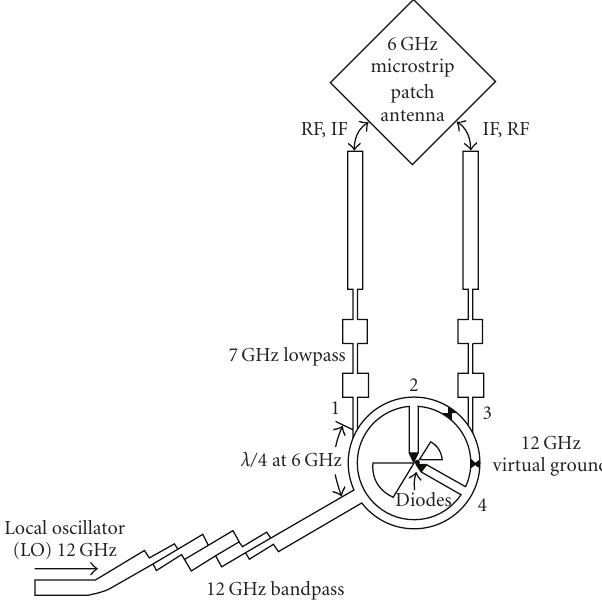
Figure 2: Phase-conjugating element using rat-race coupler.